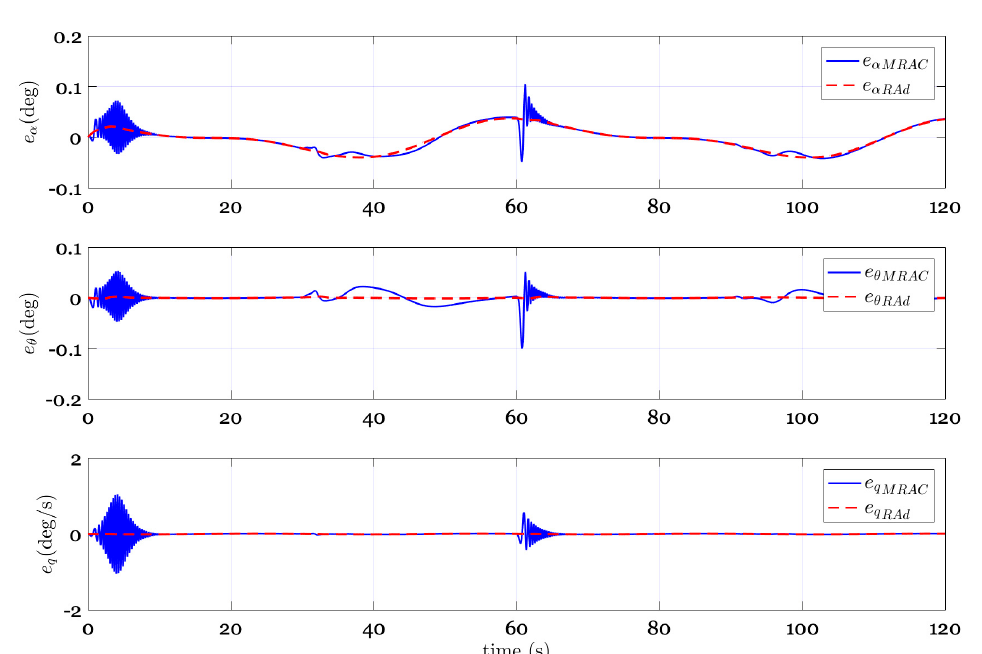
Figure 6. Aircraft response for MRAC and robust adaptive controller with ρ λ = ρ θ = 1.